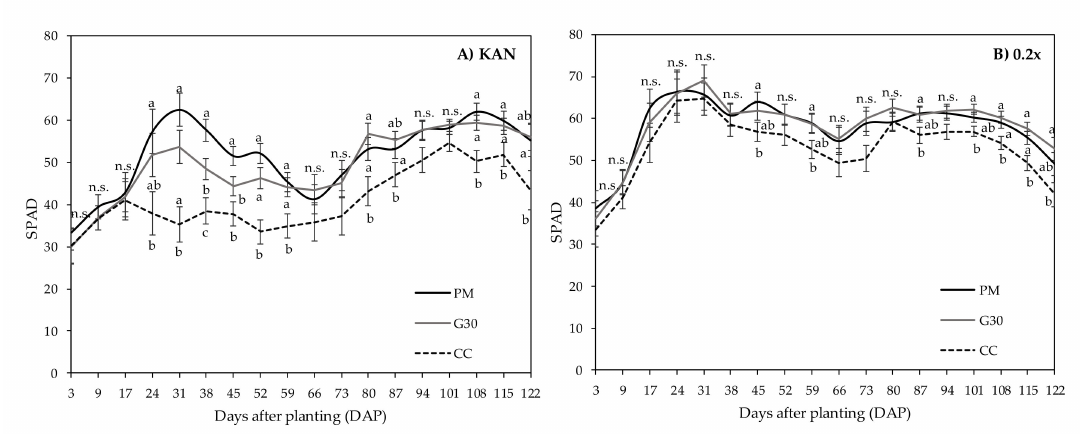
Figure 2. Mean SPAD value of genotype ( A ) KAN and ( B ) 0.2x, grown on peat-mix (PM), peat-mix + 30% green fibre (G30) and 100% coco coir (CC) fibre substrates over a time period of 122 days after planting (DAP). Means with at least one identical lowercase letter did not di ff er significantly at α = 0.05; n.s. = not significant.